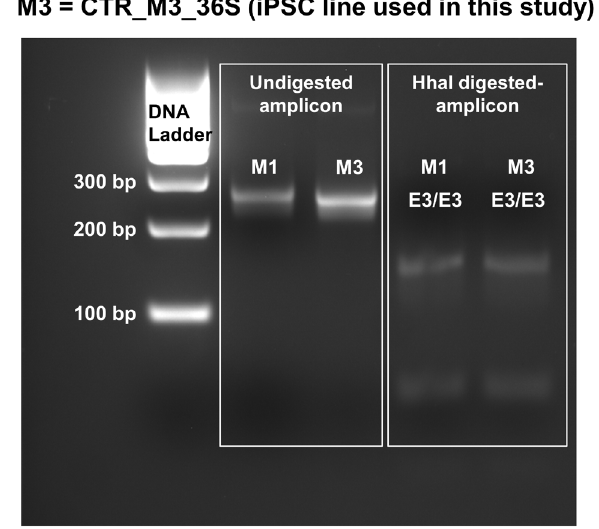
Figure 1. APOE genotyping of the cell line used in this study. CTR_M3_36S human iPSC line derived from a neurotypical male is homozygous for APOE3 (denoted as M3 in this figure). CTR_M1_04 human iPSC line that was known to be homozygous for APOE3 was used as control (denoted as M1 in this figure). HhaI-digested PCR amplicons were run on a 3% agarose gel, and the band loci were compared with the data previously reported by Henderson and colleagues who developed this genotyping method (Henderson et al. , 2002). The band loci for both CTR_M3_36S and CTR_M1_04 lines match with the homozygous APOE3 data reported by Henderson and colleagues (see Figure 1 of Henderson et al. ,